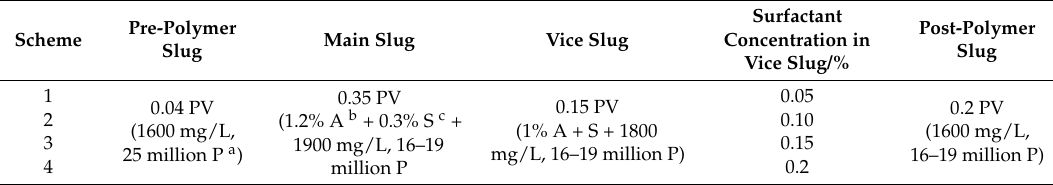
Table 8. Concrete schemes of the oil displacement with different surfactant concentrations in the vice